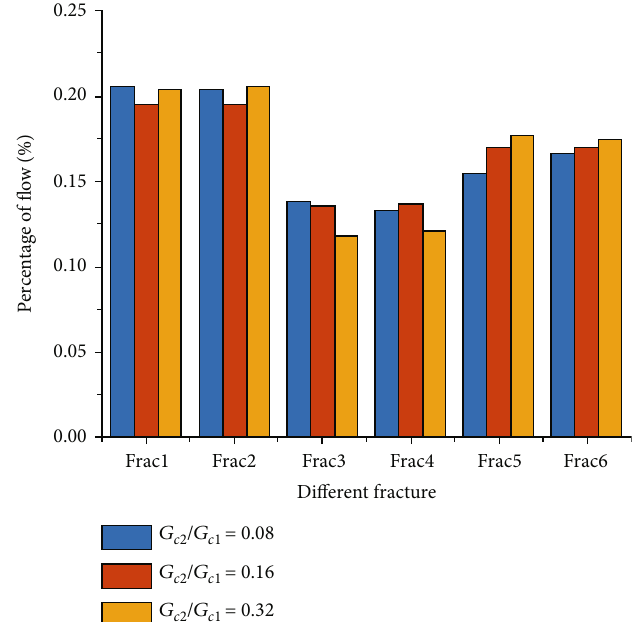
Figure 15: Fluid distribution in fractures for varying fracture energy.